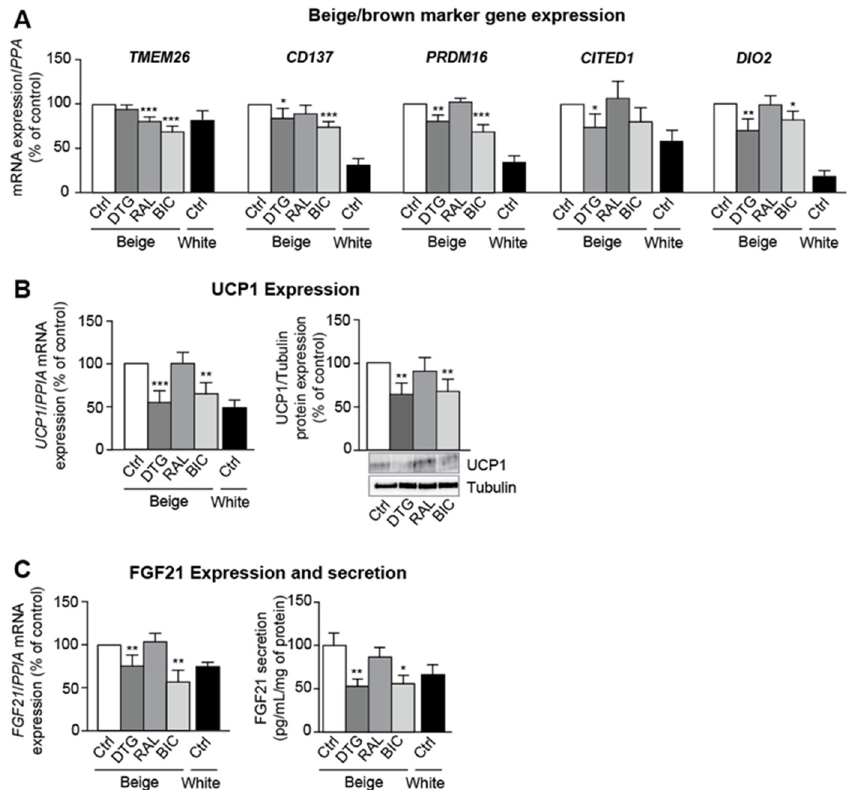
Figure 3. INSTI treatment during beige adipocyte differentiation is associated with the inhibition of beige adipogenesis. ASCs were differentiated into beige adipocytes in the presence of DMSO (Ctrl), dolutegravir/DTG, raltegravir/RAL, or bictegravir/BIC or differentiated into white adipocytes with DMSO (Ctrl) for 14 days. ( A ) Relative mRNA expression levels of TMEM26, cluster of differentiation 137 (CD137), PRDM16, Cbp/P300-interacting-transactivator-1 (CITED1), and iodothyronine-de-iodinase-2 (DIO2), were normalized against that of PPIA . The results are expressed as the mean ± SEM % of control cells ( n = 9, in duplicate). ( B ) Relative mRNA expression levels of uncoupling protein 1 (UCP1) was normalized against that of PPIA (left panel). The results are expressed as the mean ± SEM % of control cells ( n = 9, in duplicate). Whole-cell lysates were prepared and analyzed using immunoblots. Representative immunoblots of UCP1 and tubulin are shown (right panel). Densitometry analyses against tubulin as loading control were performed and expressed as a mean % of the value for control cells ± SEM ( n = 6). ( C ) Relative mRNA expression of fibroblast-growth factor-21 (FGF21) was normalized against that of PPIA (left panel). The results are expressed as the mean ± SEM % of control cells ( n = 9, in duplicate). After 14 days of differentiation with INSTIs, the levels of FGF21 in the culture medium (right panel) from the last 48 h were determined with ELISA ( n = 6, in duplicate). The results are expressed as the mean ± SEM. * p < 0.05, ** p < 0.01, *** p < 0.001 vs. control cells. 3.4. Dolutegravir and Bictegravir Are Associated with Impaired Mitochondrial Integrity in Beige Adipocytes